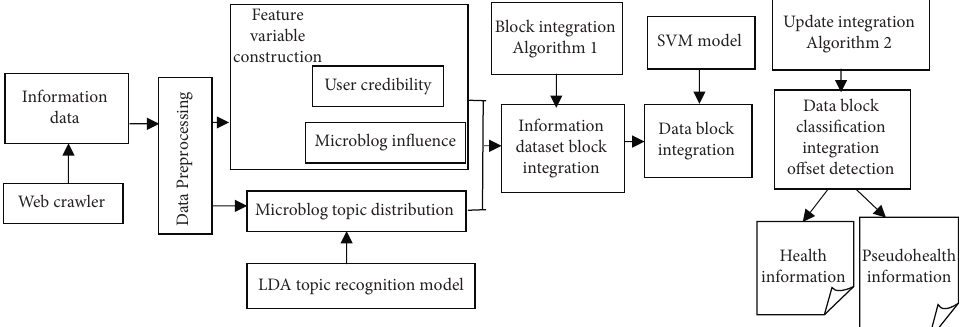
Figure 1: Logical framework of combined